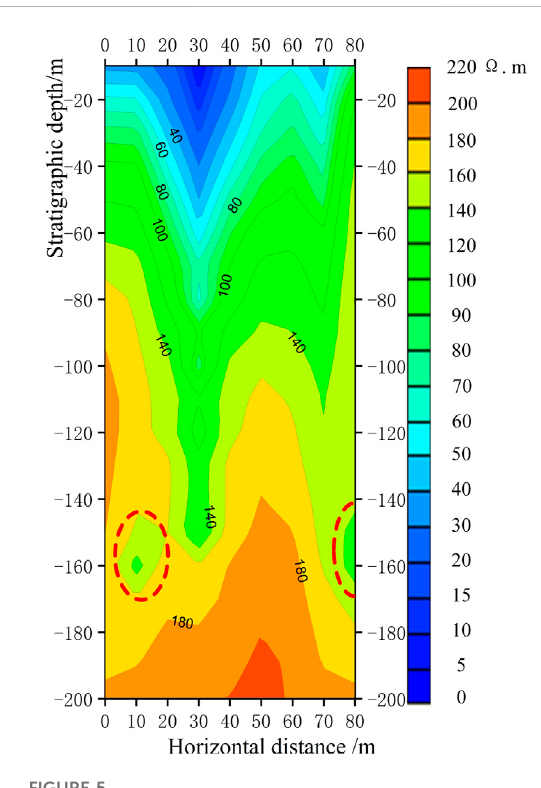
FIGURE 5 Longitudinal section view of resistivity of X 2 line.